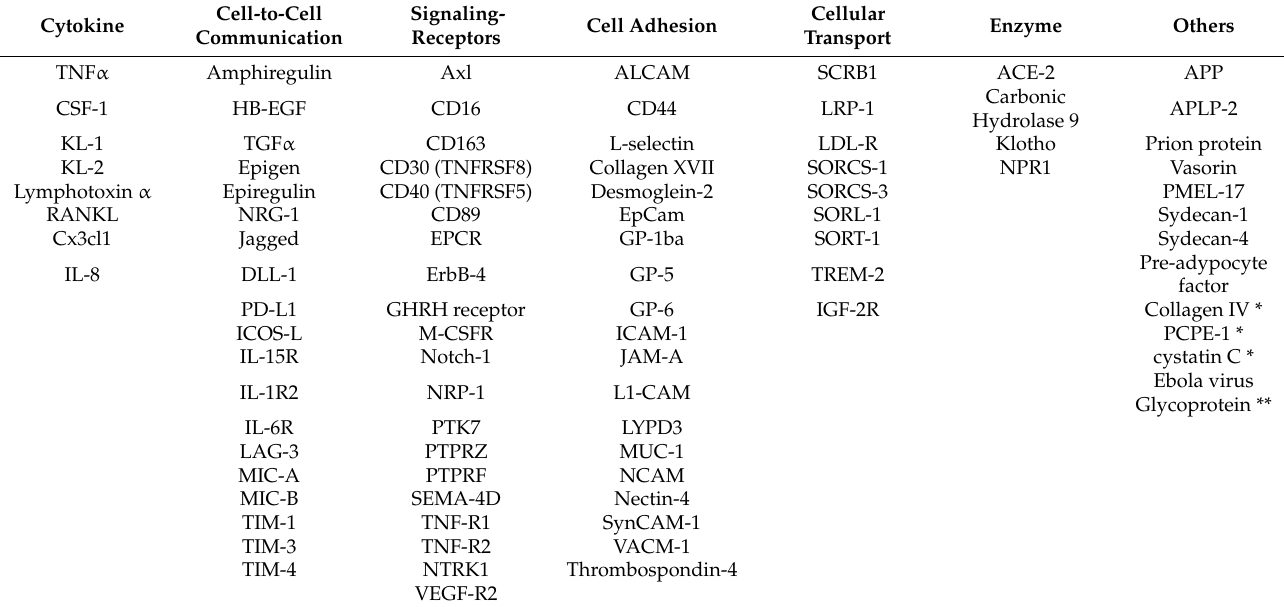
Table 1. List of known ADAM17